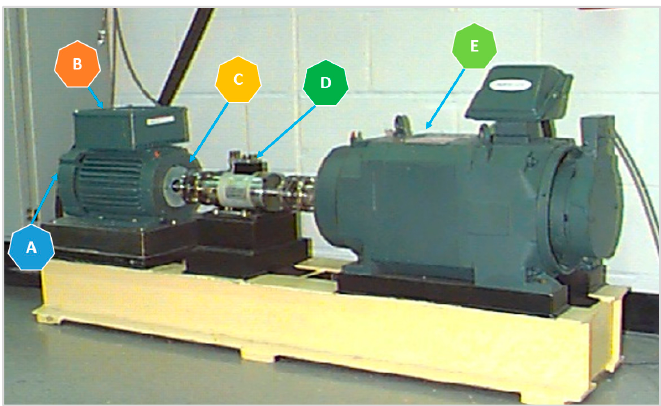
Figure 6. Bearing test ring. A = fan end bearing; B = electronic motor; C = drive end bearing; D = torque transducer; E = dynamometer.